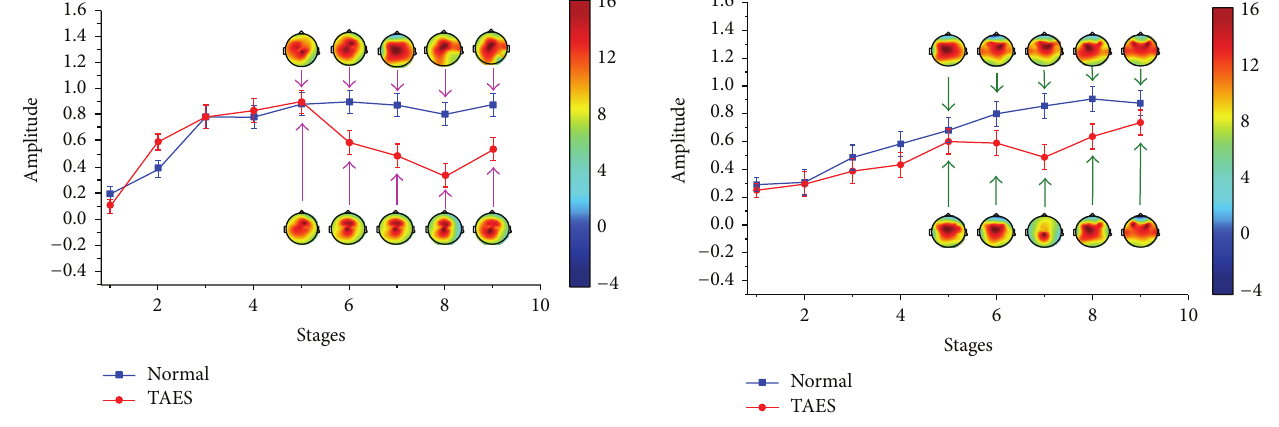
Figure 5: Relative power spectrum (mean ± S.D.) of 𝜃 subband for 9 stages of